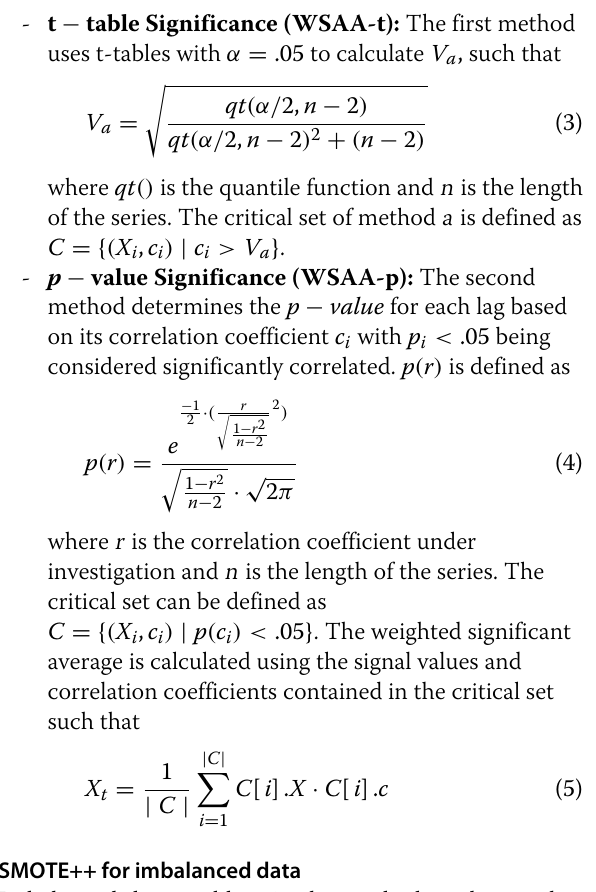
determining the threshold V for critical correlation are considered. - t − table Significance (WSAA-t): The first